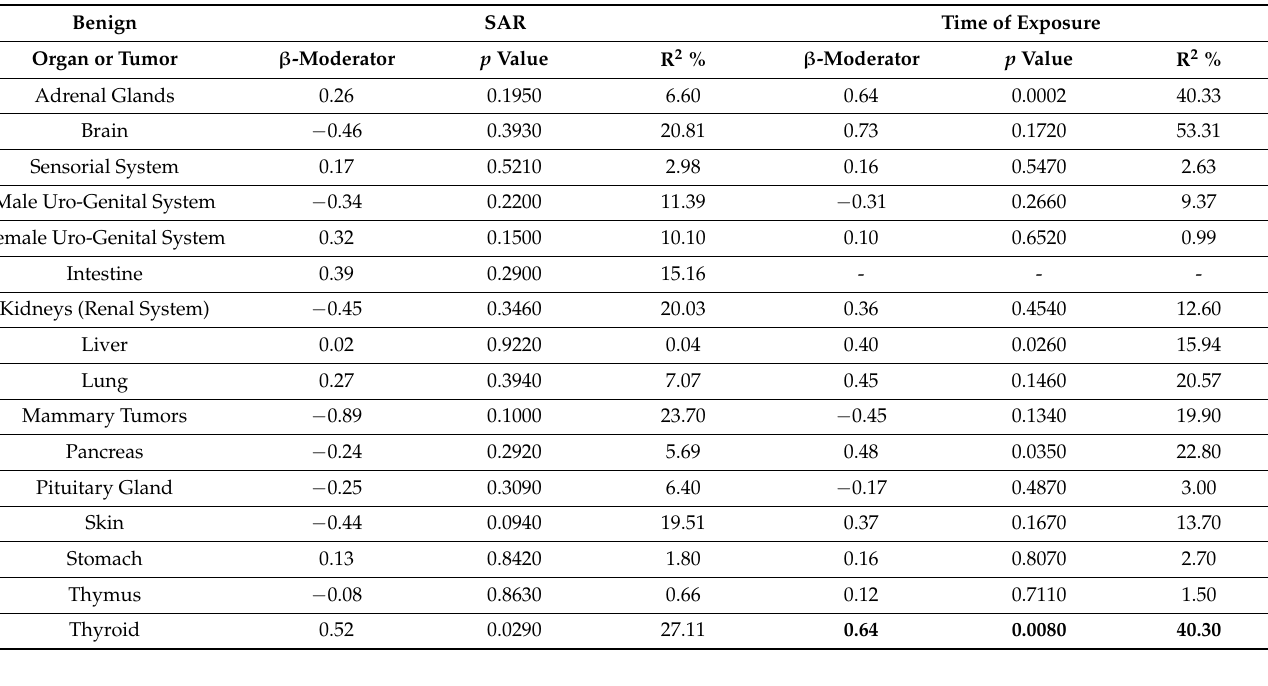
data confirm the high discontinuity of exposure times and significantly reduce confidence in the obtained result. Table 9. Summary table of linear regression analysis for benign tumors: the selected covariates are the dose (wbSAR) and the overall exposure time. Bold items represent the results with statistical significance.